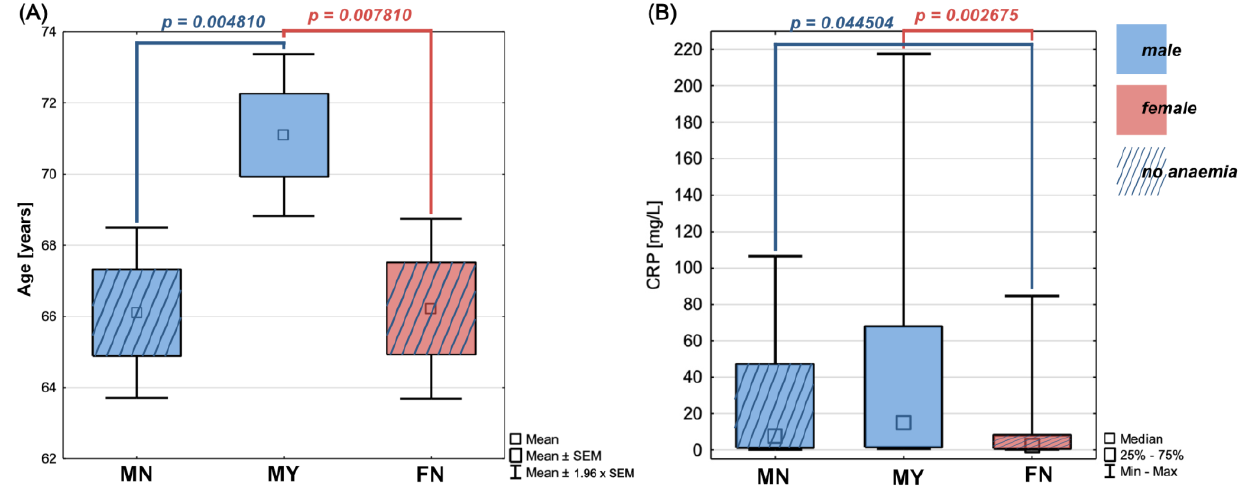
Figure 4. Age ( A ) and CRP levels ( B ) disparities between patients with and without pre-operative anaemia; MN — males without anaemia; MY — males with anaemia; FN — females without anaemia.